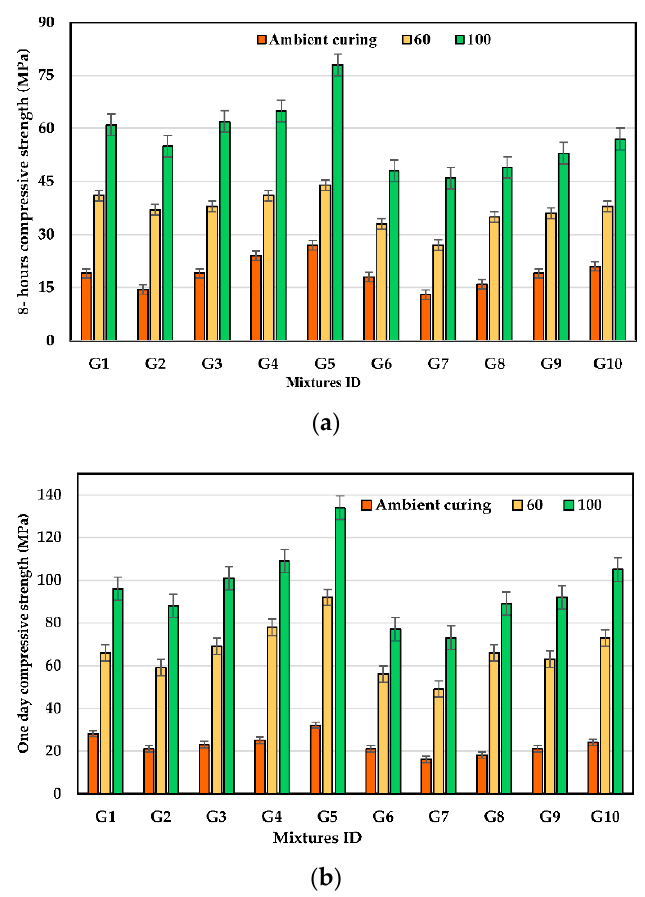
Figure 6. Effect of curing temperature and ASM type on early CS at KOH molarity of 16. ( a ) CS after 8 h; ( b ) CS after 24